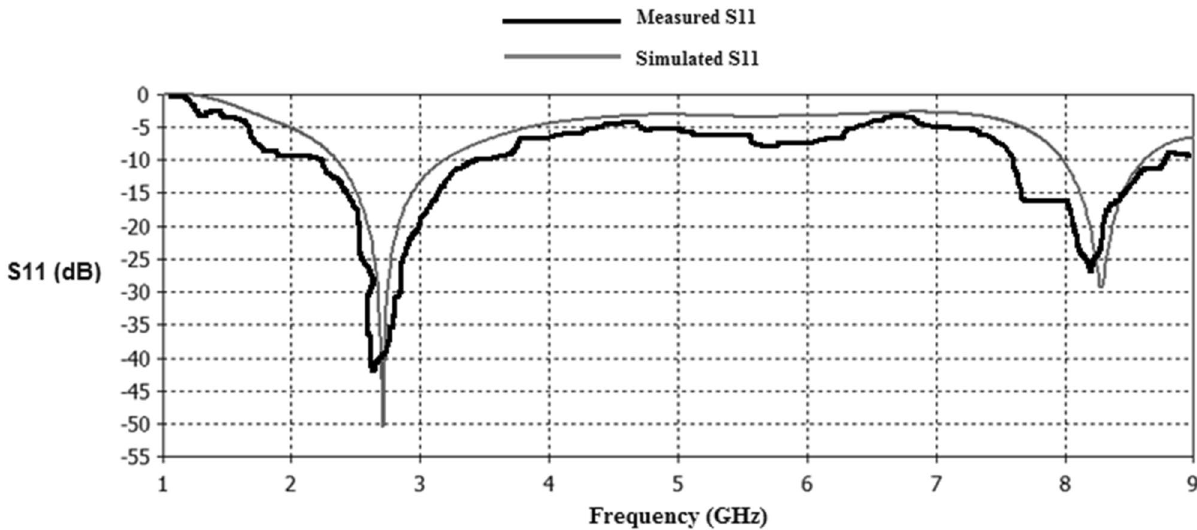
Figure 27. Simulated and measured S11 responses of Antenna1.